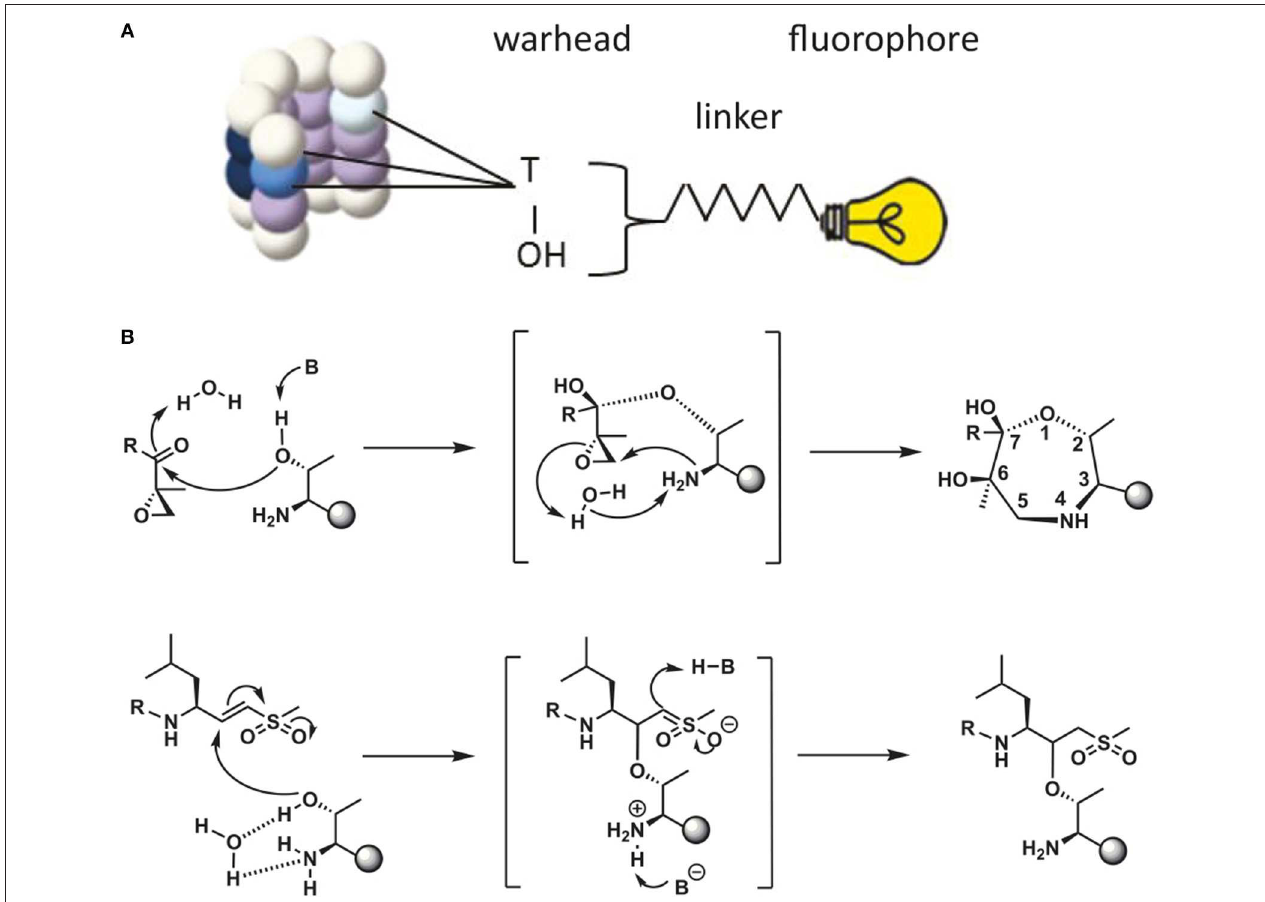
FIGURE 2 | Schematic representation of ABP reaction mechanism. (A) Schematic representation of a proteasome activity-based probe (ABP). Labeling of active proteasomes occurs via a nucleophilic attack of the proteasome active threonine residue at the electrophilic trap of the ABP, which in turn captures the catalytic threonine via a covalent bond. A fluorophore can be connected to the probe via a linker for visualization. (B) Reaction mechanisms of epoxyketone (upper) ( Borissenko and Groll, 2007; Schrader et al., 2016 ) and vinyl-sulphone (lower) (Borissenko and Groll, 2007). Electrophilic traps react with the N-terminal Threonine residue of